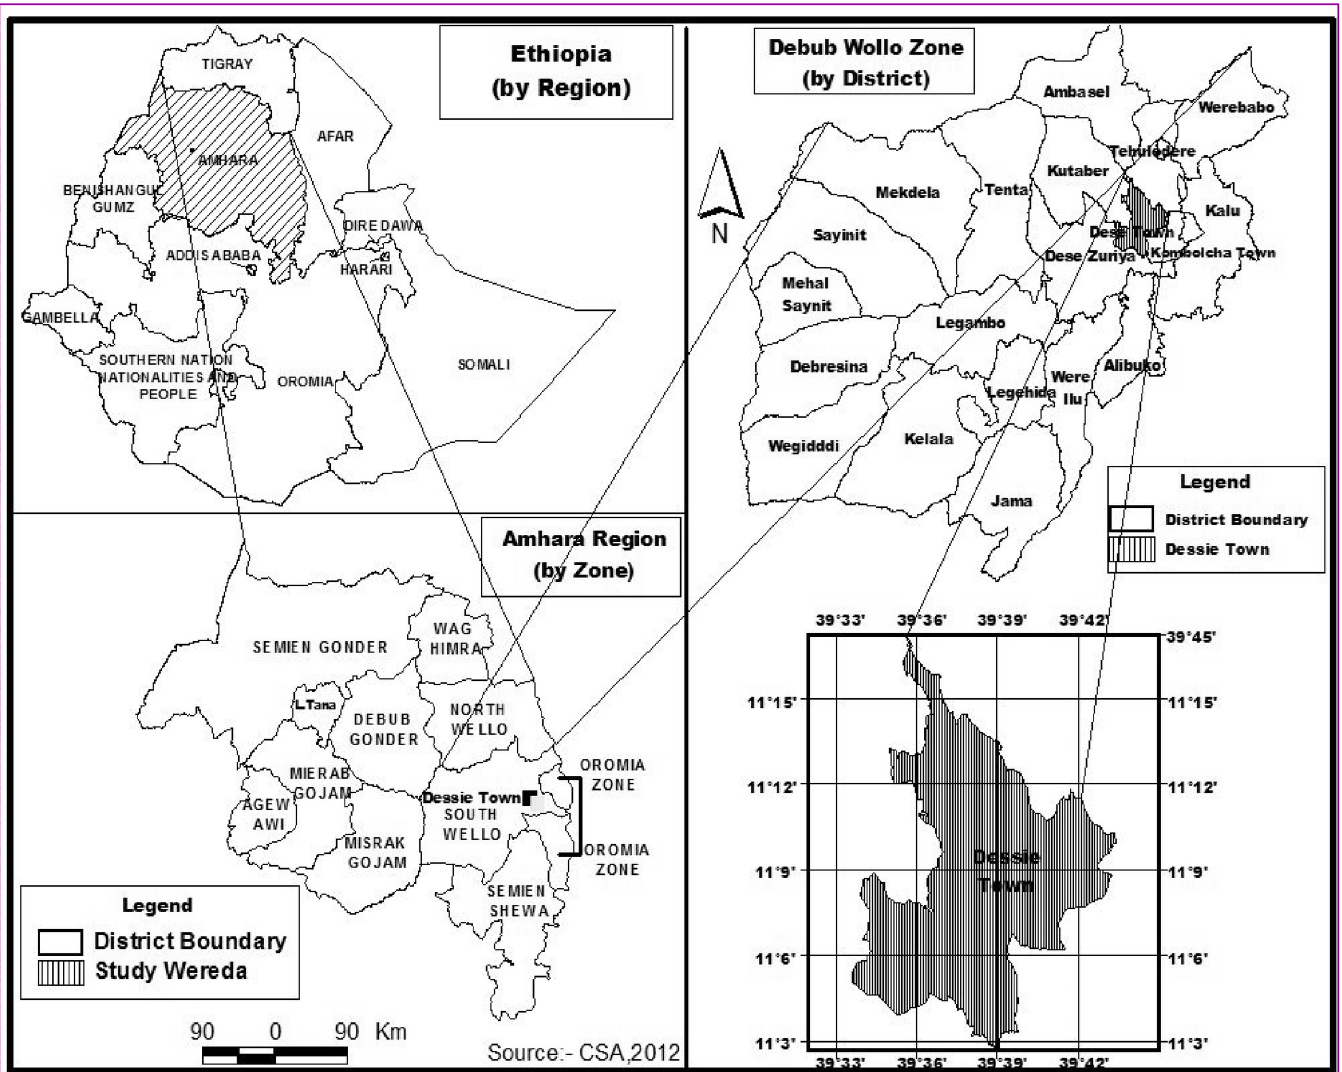
Fig 1. Map of the study